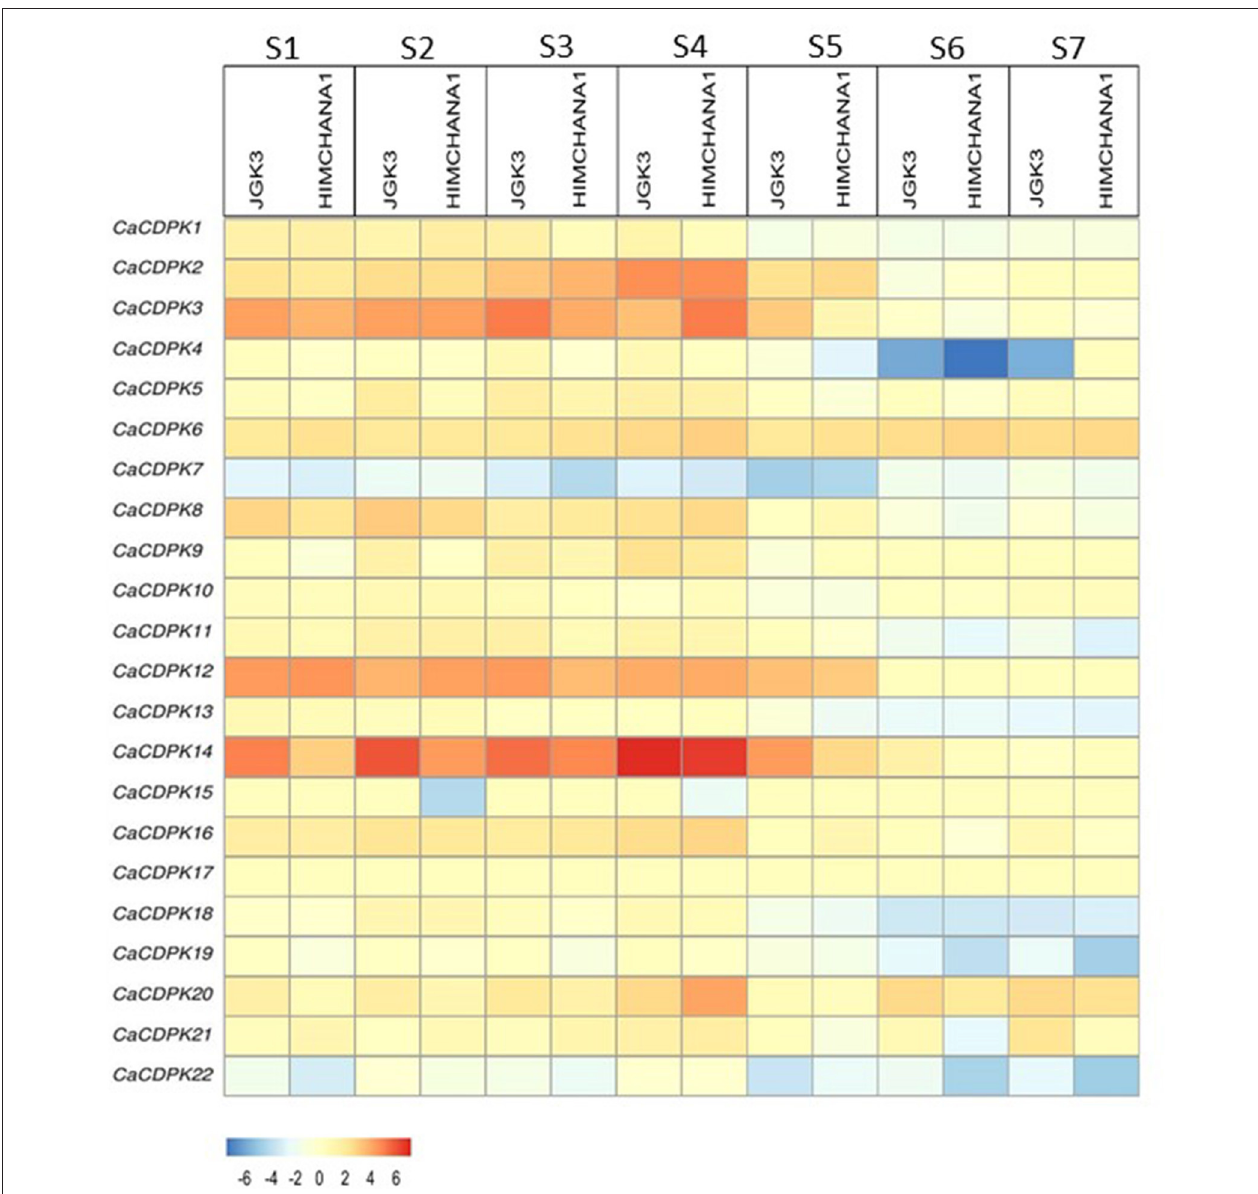
FIGURE 8 | Expression profiles of CDPK genes during different stages of seed development in chickpea. Expression profiles are shown for seven seed developmental stages (S1–S7) in two chickpea cultivars: large-seeded JGK3 and small-seeded Himchana1. The genes are named on the left and stages/cultivars are labeled at the top. The scale bar represents the log_2 Fold Change FPKM